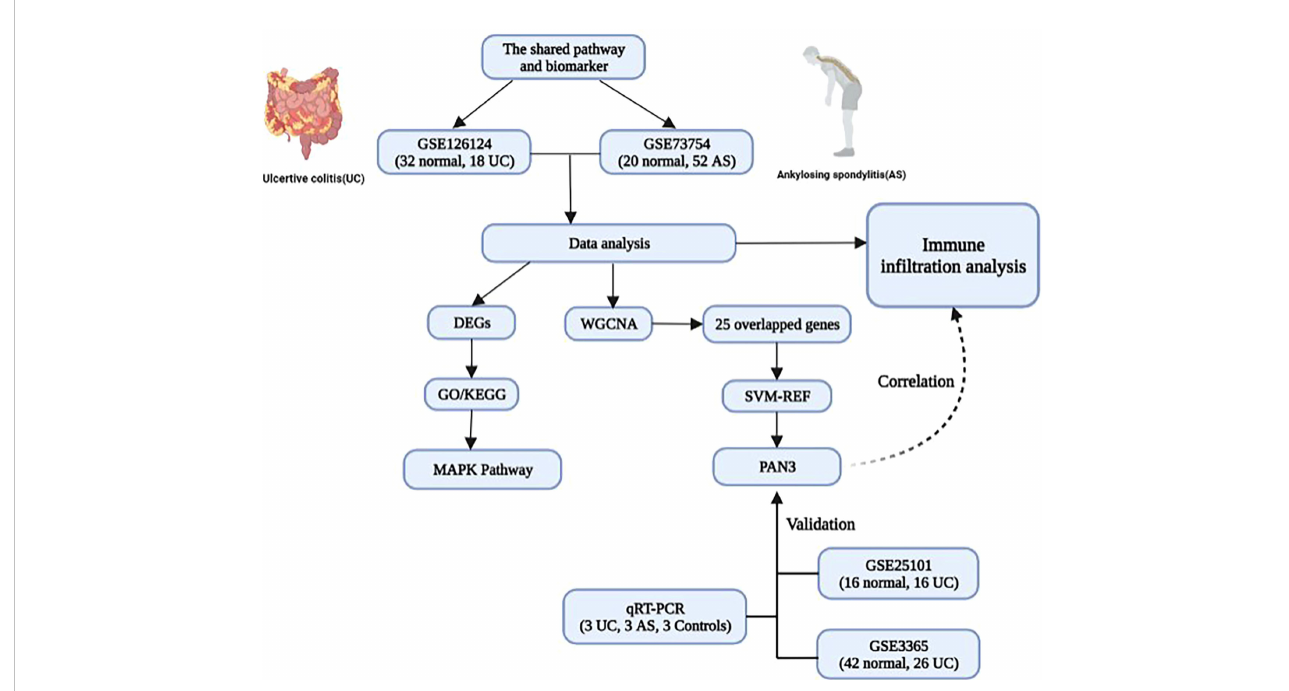
FIGURE 8 The model diagram of the shared pathway and common biomarker analysis in UC and